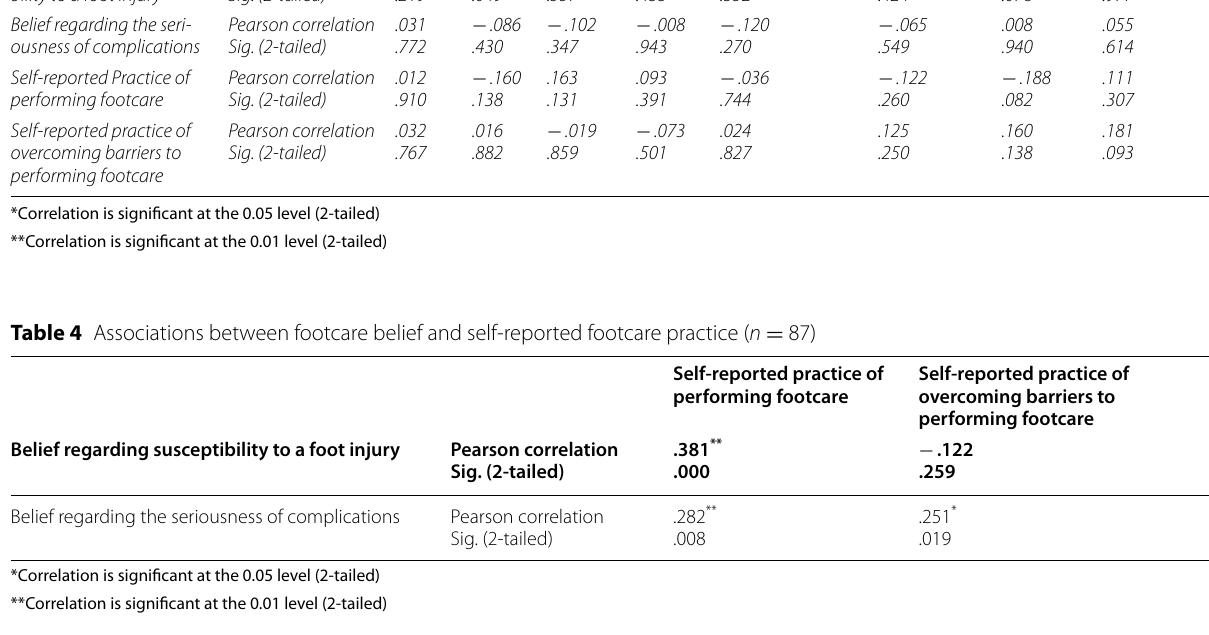
87) = Time since Health centre status diagnosis